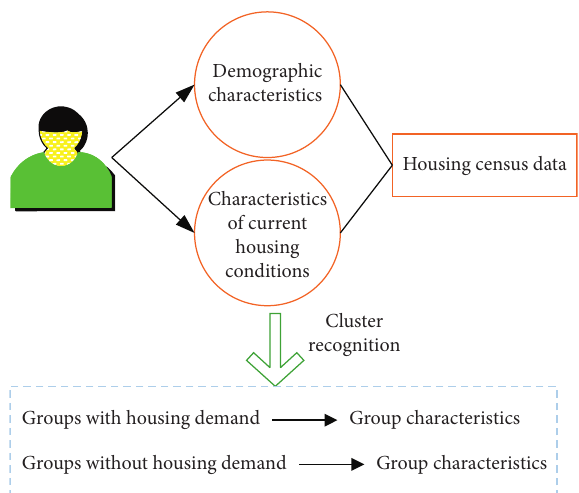
Figure 3: A residential housing demand recognition